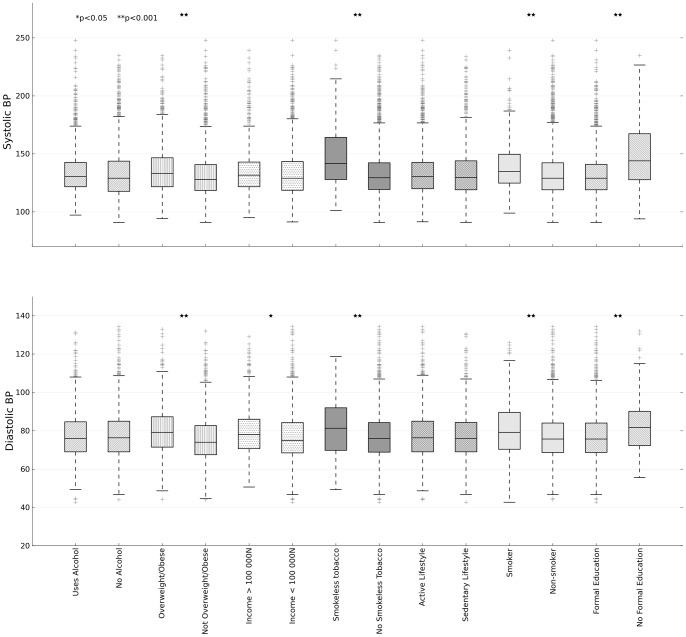
Relationship between selected non-communicable diseases and mean systolic and diastolic blood pressures.